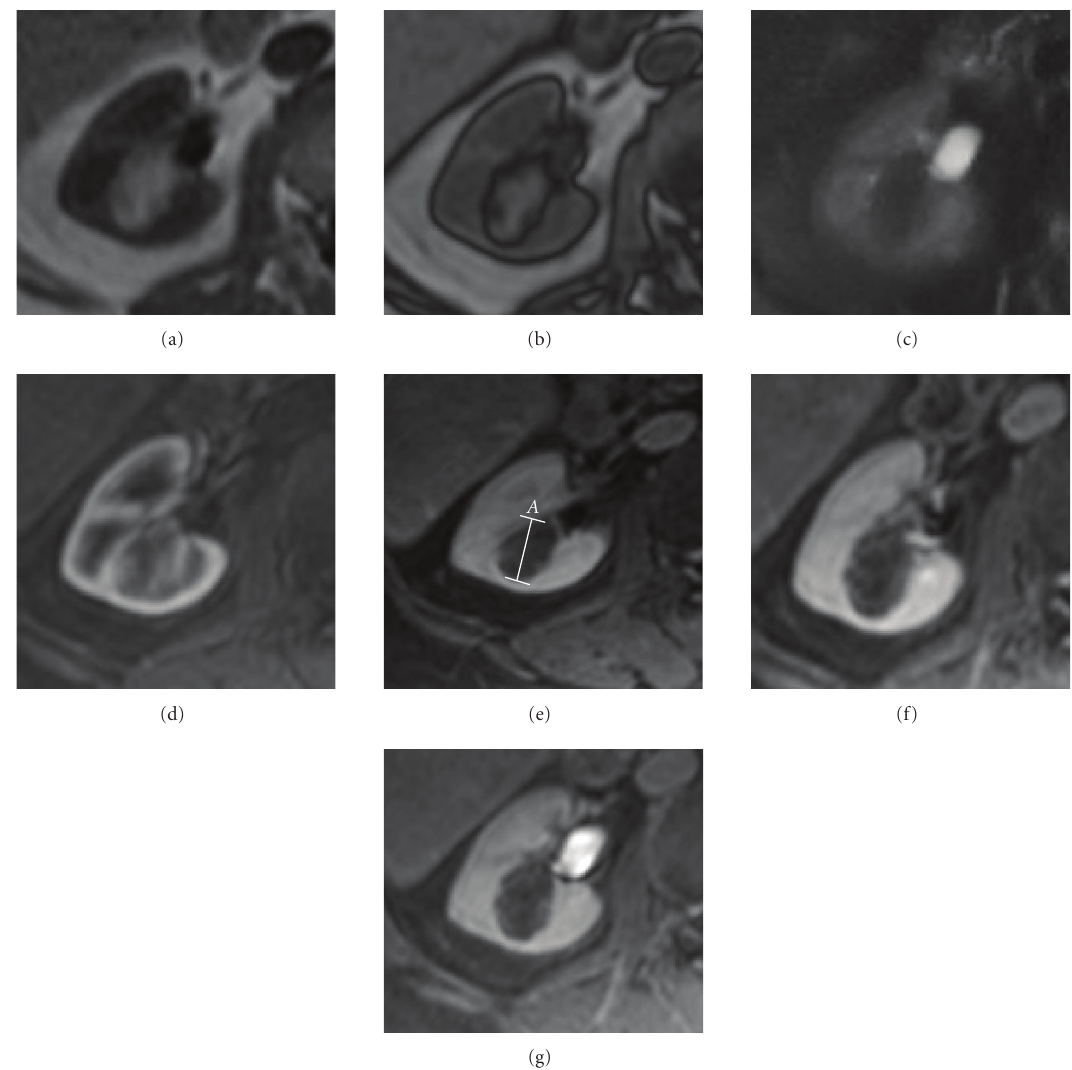
Figure 12: (a) Axial T1 in phase, (b) axial T1 out of phase, (c) axial haste T2 with fat saturation, and ((d–g) axial dynamic postcontrast T1 (d), arterial; (e), venous; (f), nephrographic, and (g), excretory phase): right yuxtahilar renal lesion seen as a T1 hyperintense mass that shows gross fat suppression on T2 revealing macroscopic fat and also probably small foci of peripheral fat as there is a small amount of signal loss on out of phase sequence. On dynamic postcontrast images the mass shows a transitional highly peripheral enhancement in the non-fat components with poor enhancement on the remaining postcontrast study. An angiomyolipoma was found at